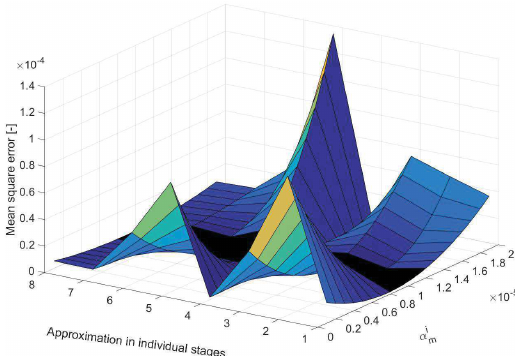
Figure 6. Residual sums of control functions with variable k i on the searched parametric space. ip